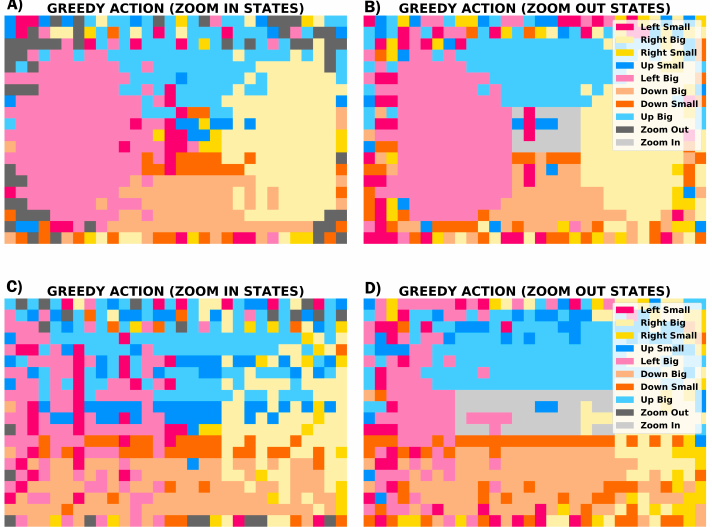
Figure 8. Example of greedy behaviour after 100,000 epochs for training a camera agent to center a blood spot through Q-Learning. The state is a different camera view of the blood trace and the ten possible actions (represented by colors) are movements of the camera respect to the whole image framework. ( A ) (ZI) and ( B ) (ZO) images corresponds to Agent 8 (Reward Shaping I) and ( C ) (ZI) and ( D ) (ZO) images are for Agent 8 (Reward Shaping